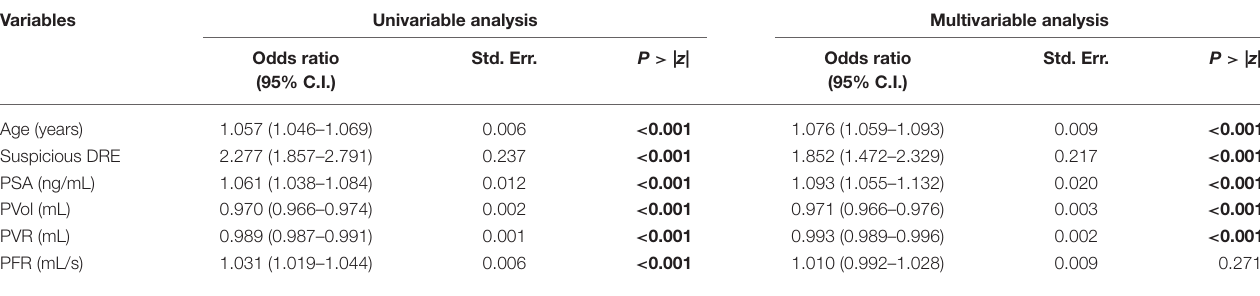
TABLE 2 | Univariable and multivariable binary logistic regression analysis testing the value of clinical variables in predicting Prostate Cancer (any ISUP).